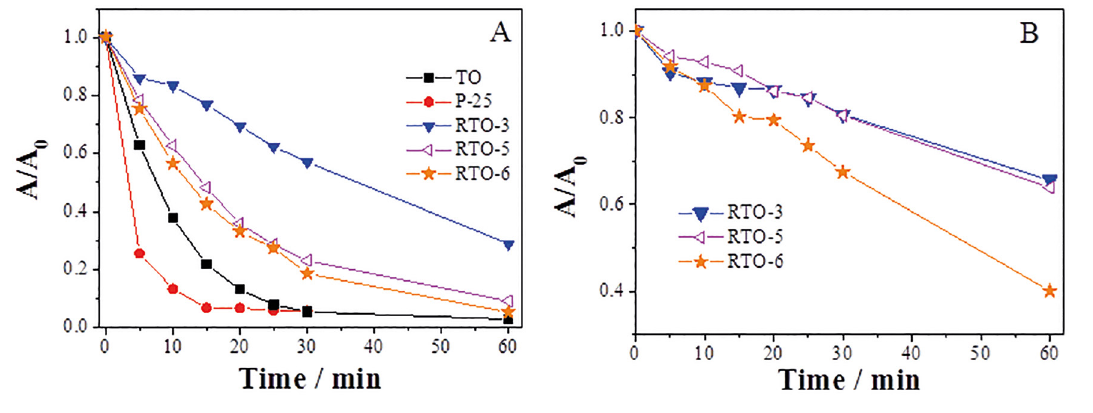
Figure 7. Photocatalytic behavior of RNO oxidation with different photocatalysts prepared by reflux syntheses using (A) UV and (B) visible radiation (250 mg of catalyst; initial concentration of RNO = 2.0 x 10 -5 mol L -1 ).